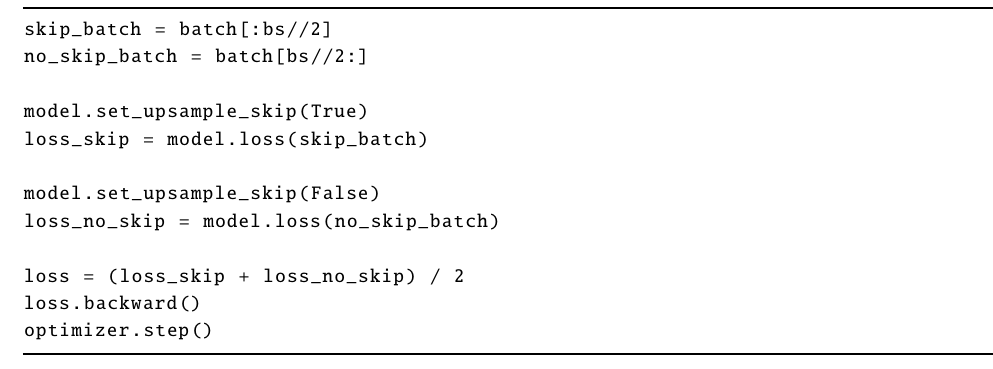
Figure 2. Code illustration of our MixSkip training